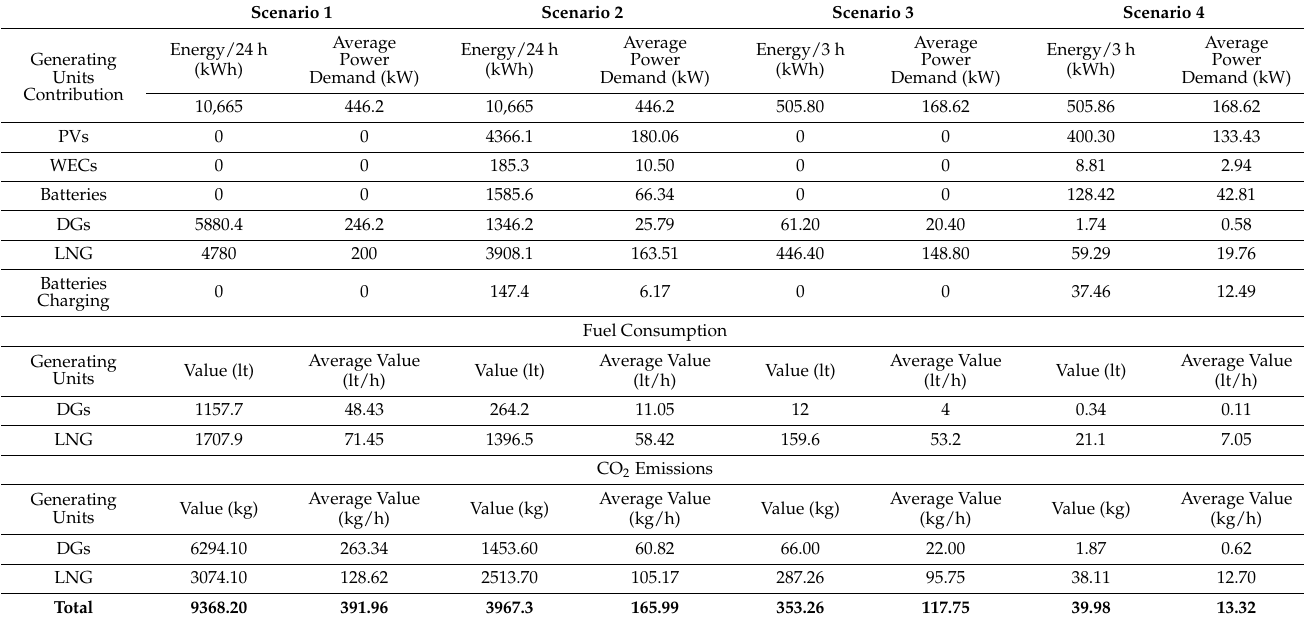
Table 8. Results of Four